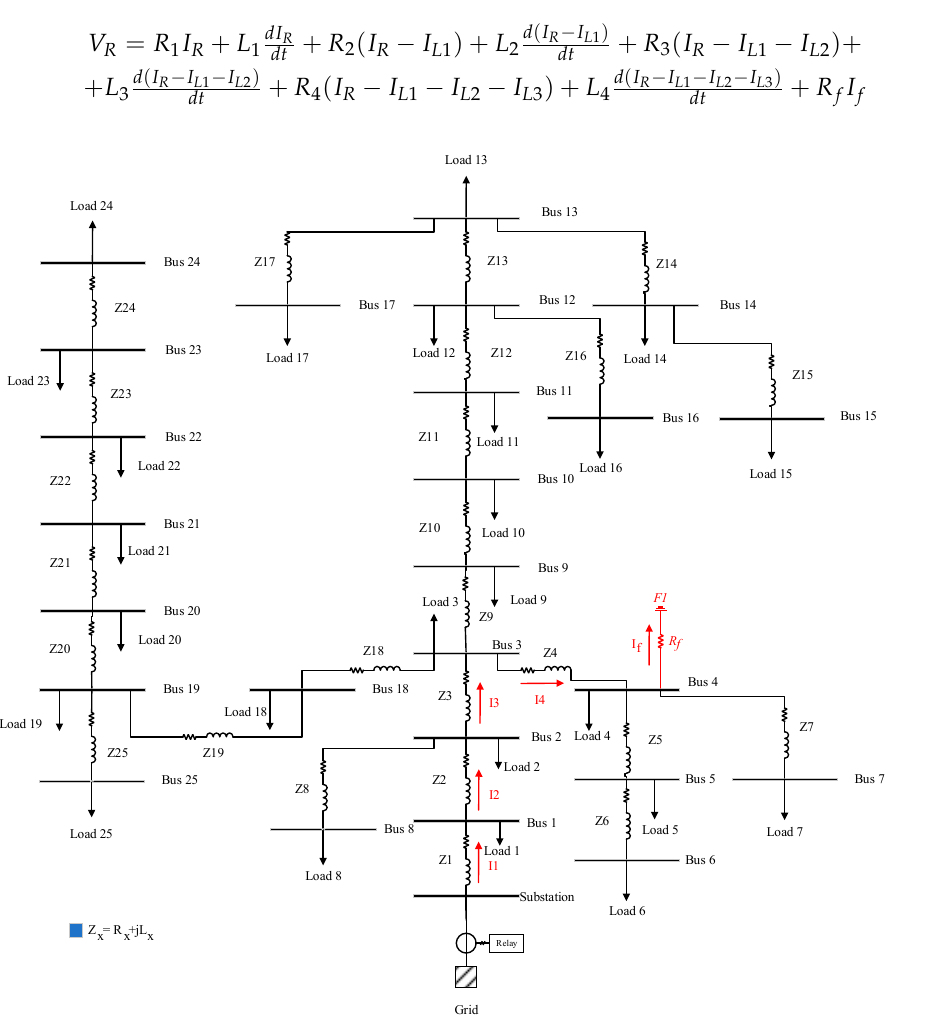
Figure 4. Structure of understudy practical distribution system.